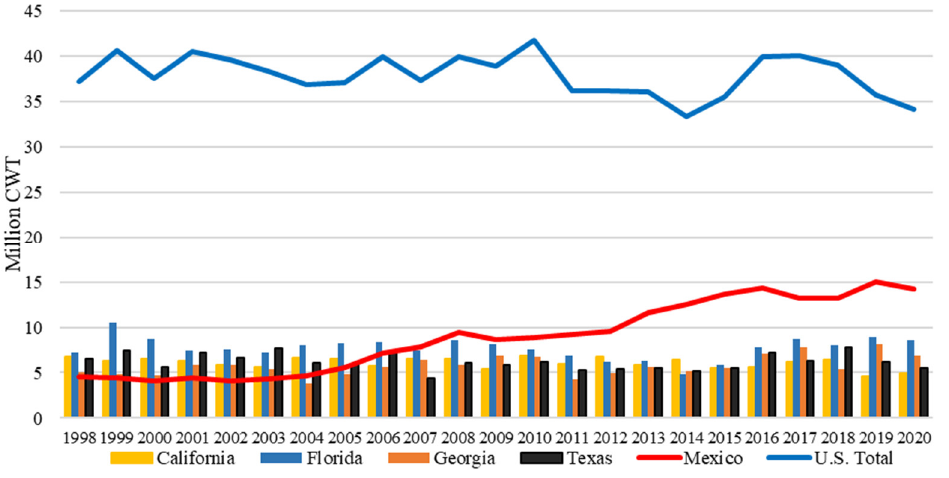
Figure 10. U.S. production and Mexican imports: fresh watermelon. Sources: USDA FAS [11]; USDA NASS [37] .